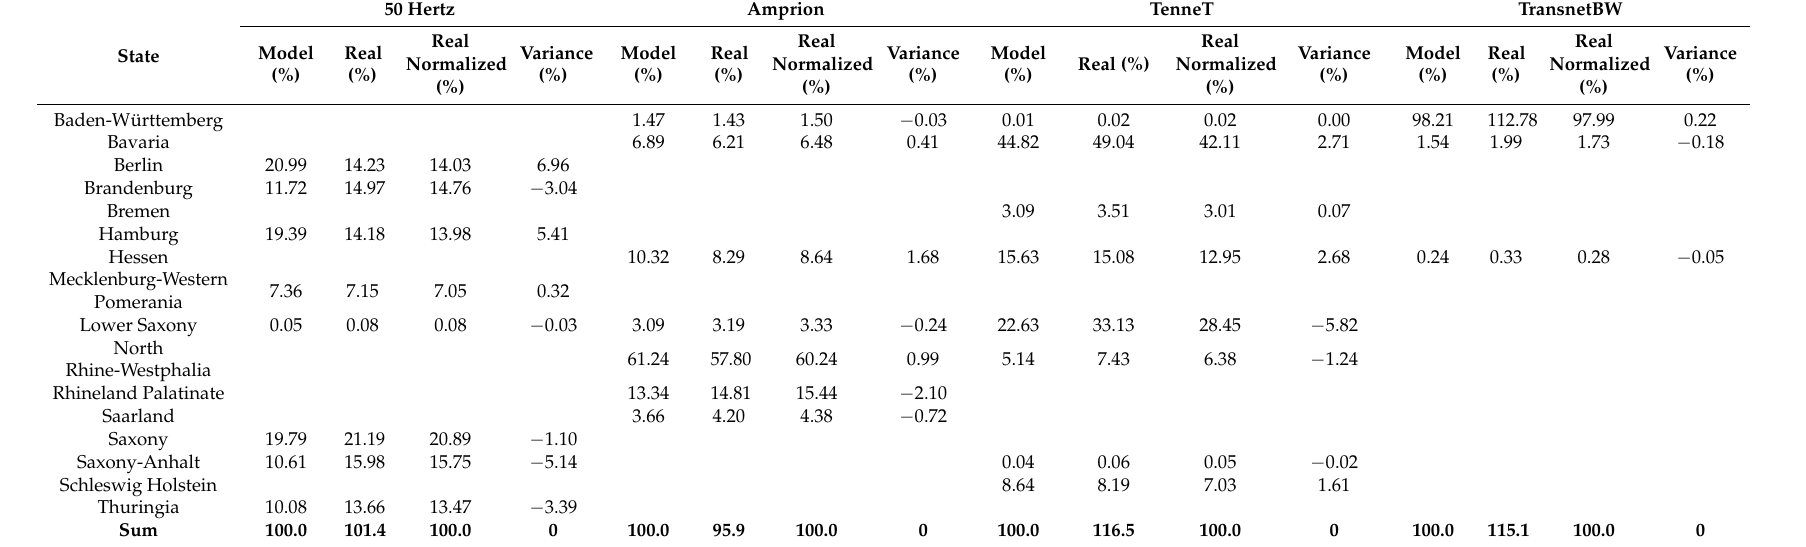
Table 6. Comparison between the modeled data, real consumption data and real normalized consumption data in